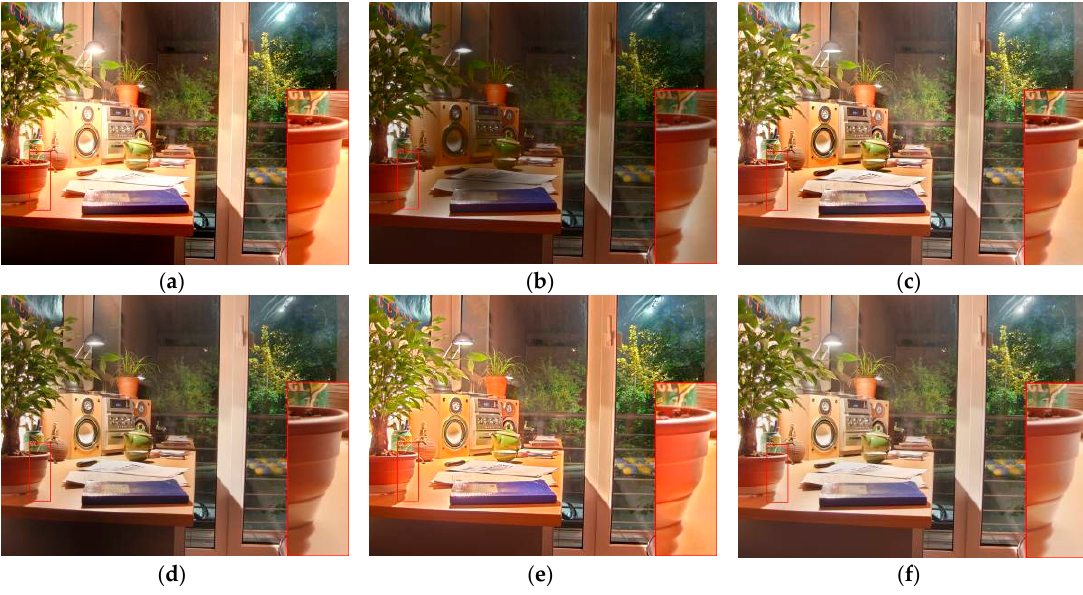
Figure 8. Performance comparison of different methods on the “recorder” image sequence. ( a ) Mertens10 [15]; ( b ) Vonikakis11 [16]; ( c ) Li13 [18]; ( d ) Liu15 [12]; ( e ) Ma18 [14]; and ( f ) the proposed method.